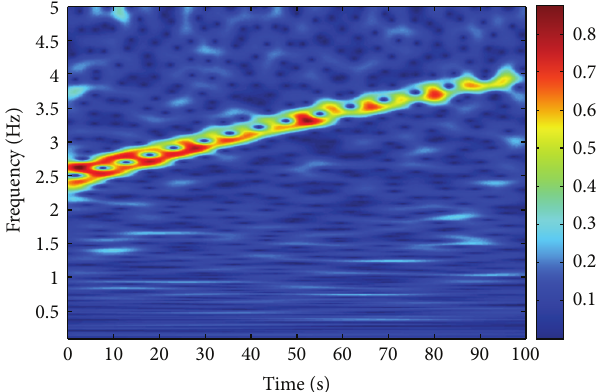
Figure 16: CWT scalogram of displacement response of case 3.